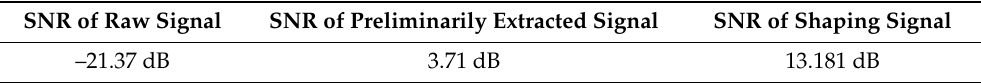
Table 1. The signal-to-noise ratio (SNR) of